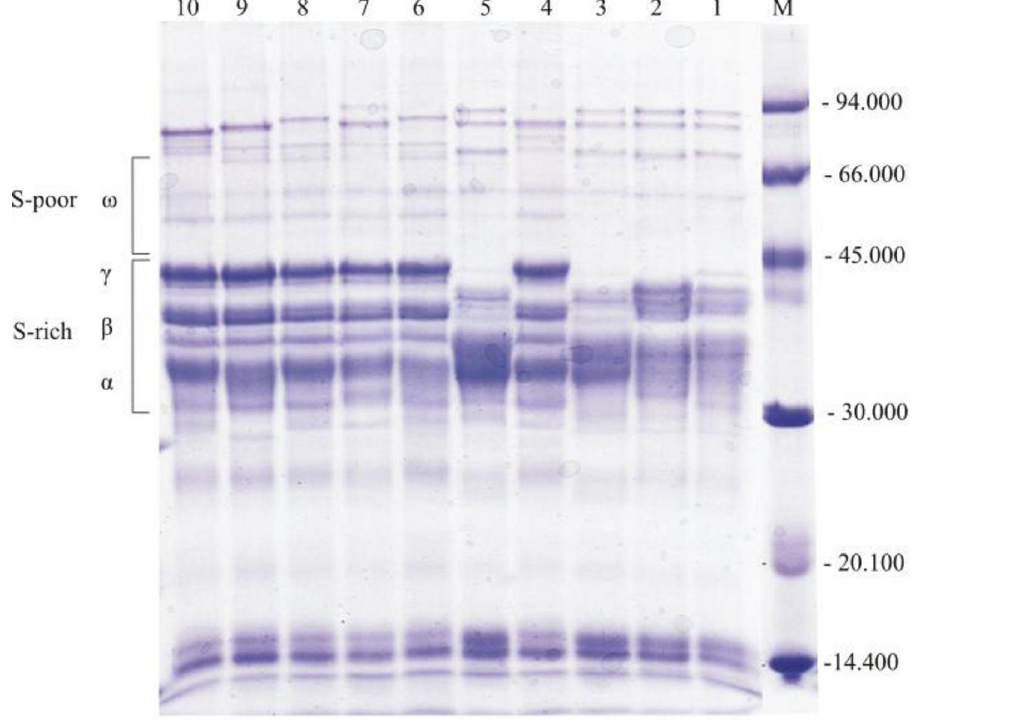
Figure 1. SDS-PAGE patterns gliadins from bread and durum wheat genotypes. ω, γ, β and α indicate subunits of gliadin. 1–5 bread wheat: 1—ZP 87/I, 2—Apache, 3—ZP Zemunska rosa , 4—ZP 224, 5—ZP Zlatna; 6–10 durum wheat: 6—ZP 34/I, 7—ZP 10/I, 8—ZP DSP/01, 9—Varano, 10—ZP 7858, M—Molecular weight